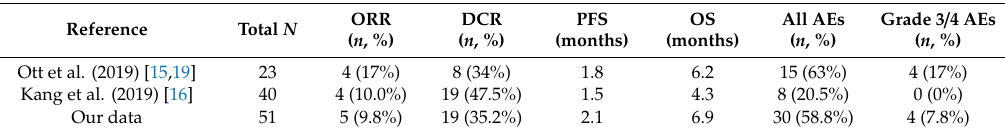
Table 5. Reported data of pembrolizumab treatment in patients with gemcitabine / cisplatin-refractory biliary tract cancer